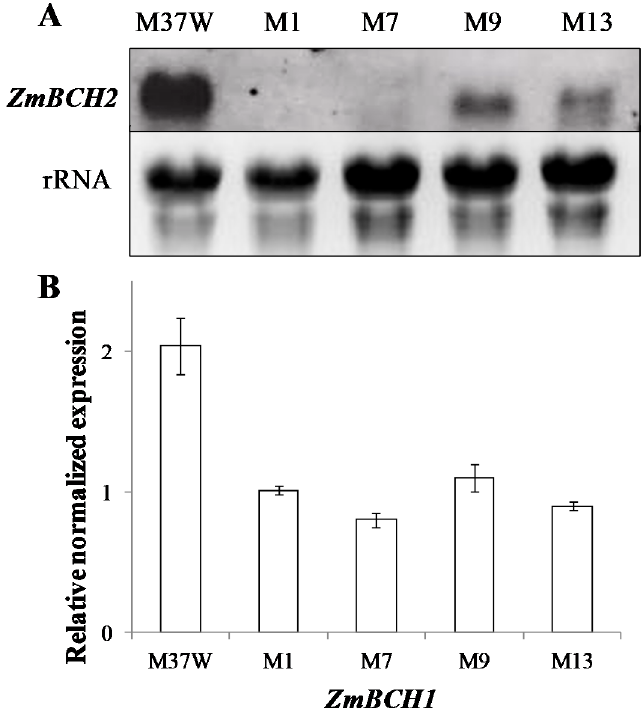
Figure 2. BCH gene expression in the endosperm of wild-type (M37W) maize and independent transgenic lines M1, M7, M9, and M13 at 30 DAP. ( A ) An mRNA blot (25 µg of total RNA per lane) to monitor ZmBCH2 expression; ( B ) Endogenous ZmBCH1 mRNA levels detected by qPCR presented as means of three replicates ± SE (standard error).